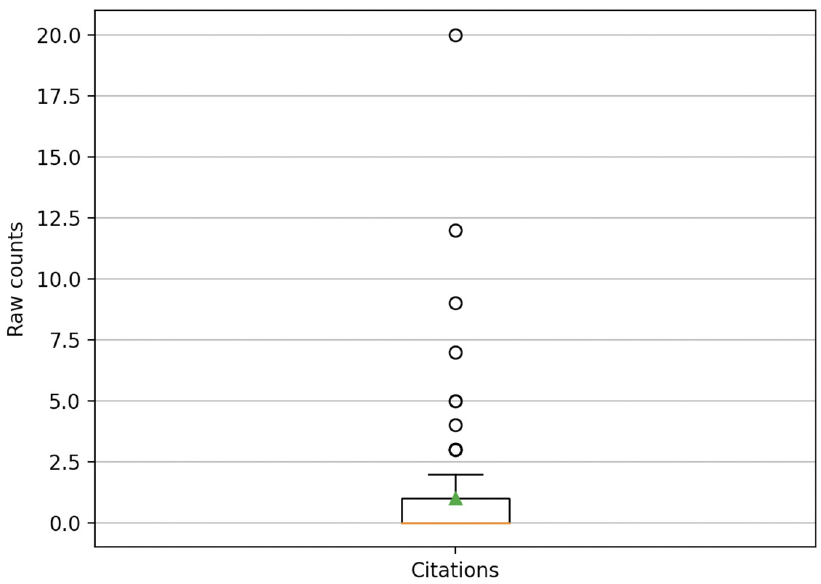
Figure 7. JOHD/RDJ data papers: boxplot showing the distribution of total citation counts.